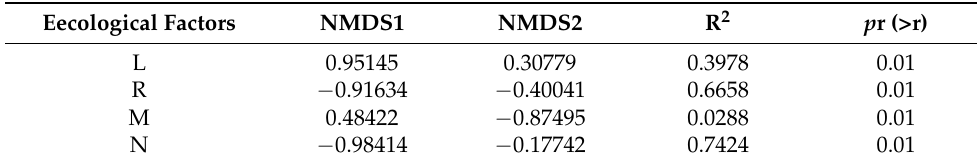
Table A1. Direction of ecological factors vectors and their correlation with points coordinates in NMDS ordination.